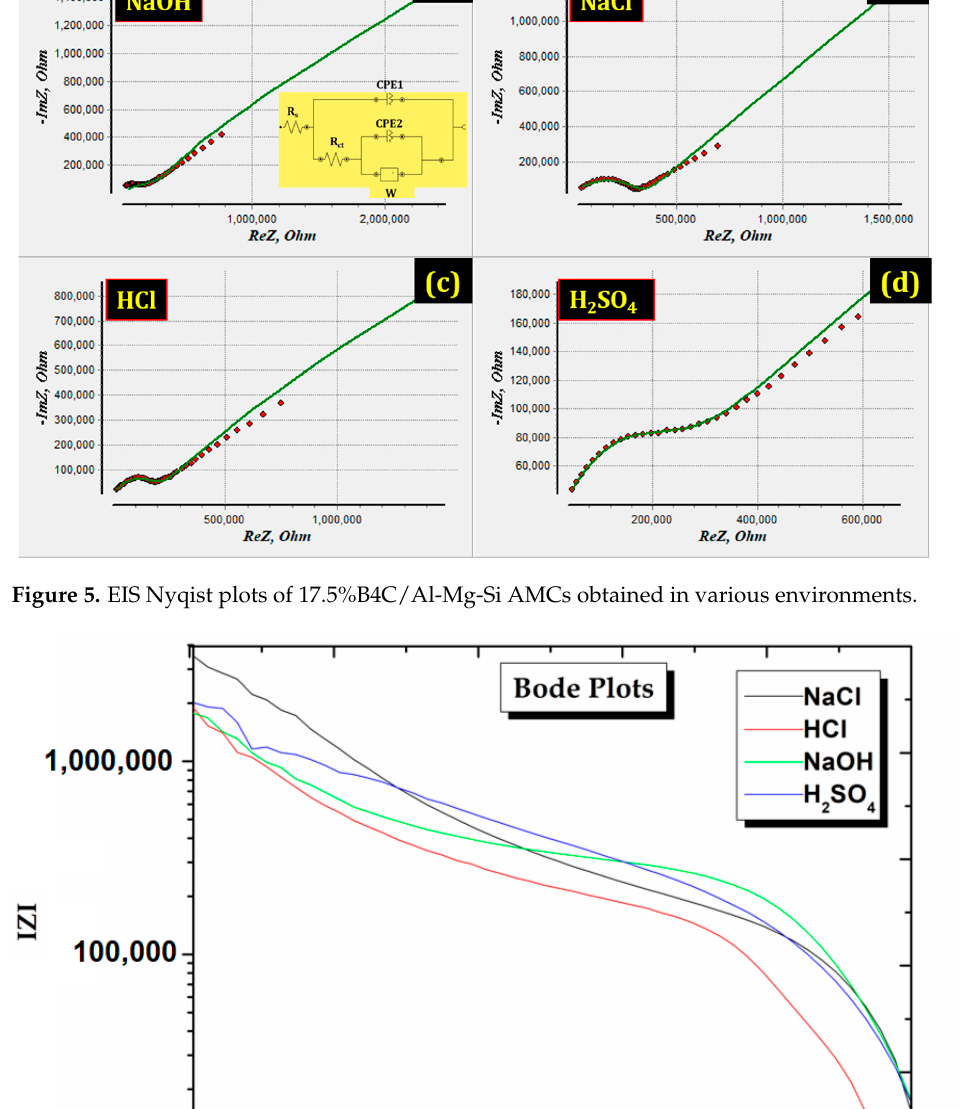
Figure 5. EIS Nyqist plots of 17.5%B4C/Al-Mg-Si AMCs obtained in various environments.